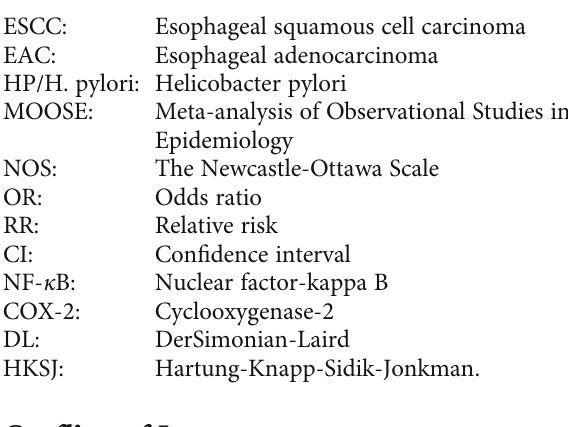
Table S1: critical appraisal of the included studies according to the Newcastle-Ottawa Scale. Table S2: assessment of risk of bias in individual studies. Table S3: checklist for Meta- analysis of